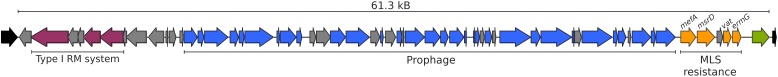
Genetic organization of the novel Clostridium difficile putative mobile element harboring the ermG gene. Restriction-modification system genes are shown in purple, prophage genes are shown in blue and the genes associated with macrolides, lincosamides and streptogramines resistance are indicated in orange. The transposase is shown in green and the interrupted gene coding for a 23S rRNA (uracil-C(5))-methyltransferase is shown in black. Genes coding for hypothetical proteins are shown in gray.